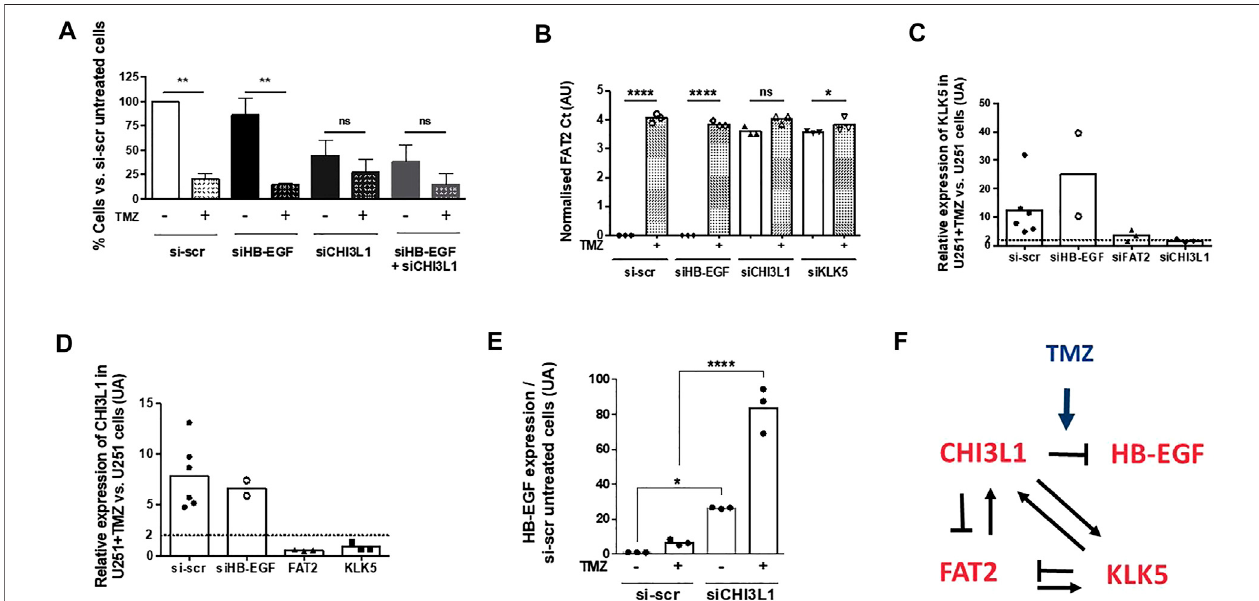
FIGURE 4 | (A) Effect of siRNA silencing of KLK5 , FAT2 , CHI3L1 , and HB-EGF on cell survival in the absence or in the presence of 50 µM TMZ (7 days treatment). Q-PCR quanti fi cation of FAT2 (B) , KLK5 (C) , and CHI3L1 (D) in U251 cells treated with siRNA directed against each of the four genes in our persister signature with or without TMZ treatment. (E) Expression of HB-EGF is increased only by CHI3L1 silencing and is enhanced by TMZ treatment. (F) Representation of the regulation loops between the four genes of our persister